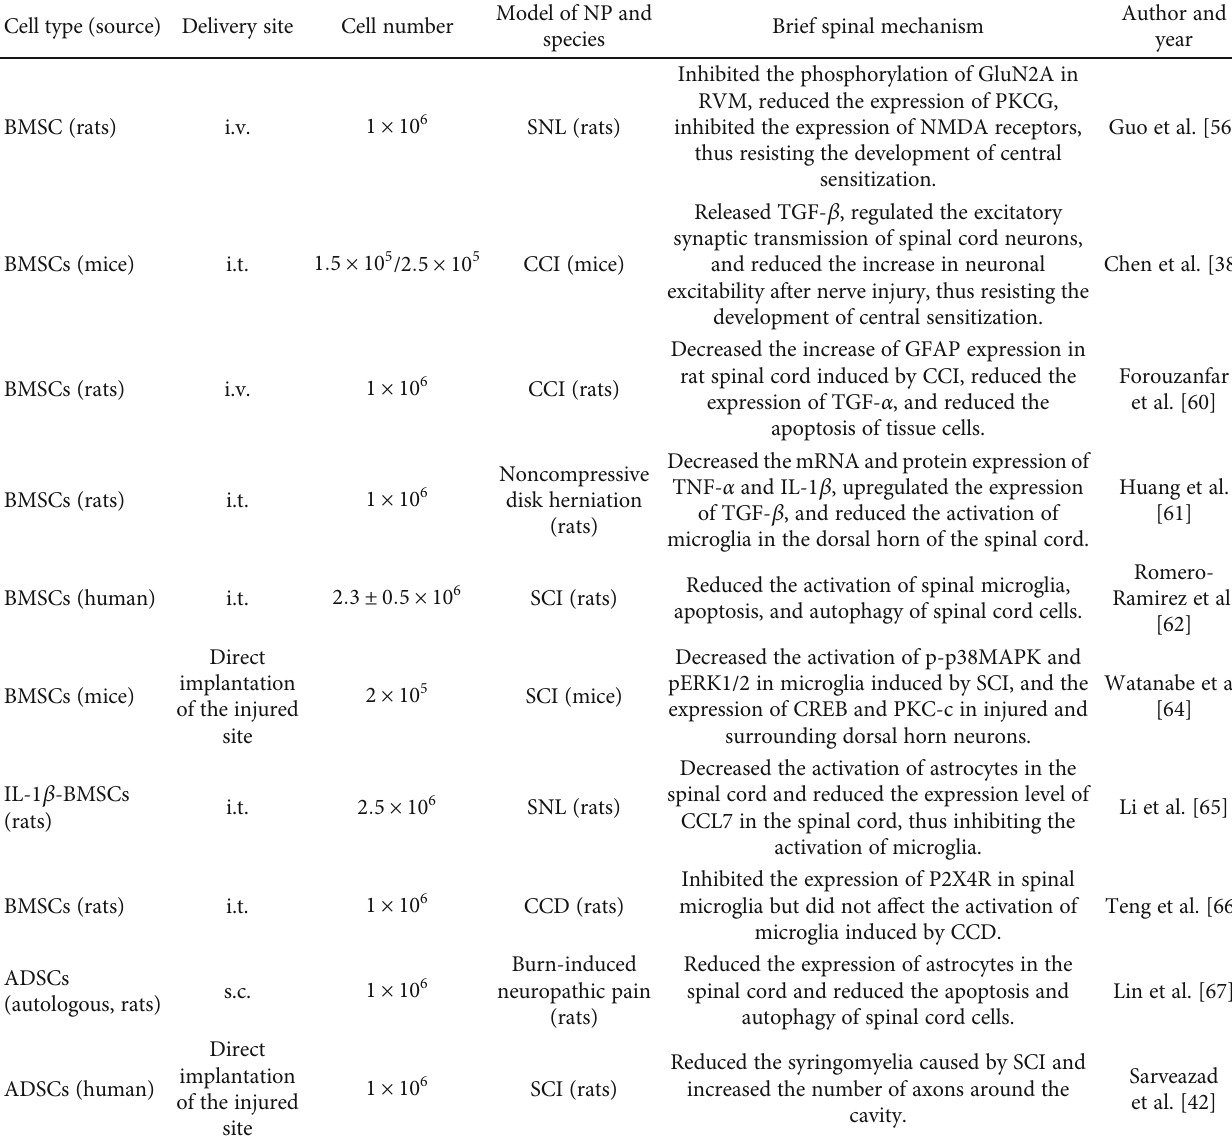
Table 3: Preclinical study of stem cells involved in spinal mechanism in the treatment of neuropathic pain. Cell type (source) Delivery